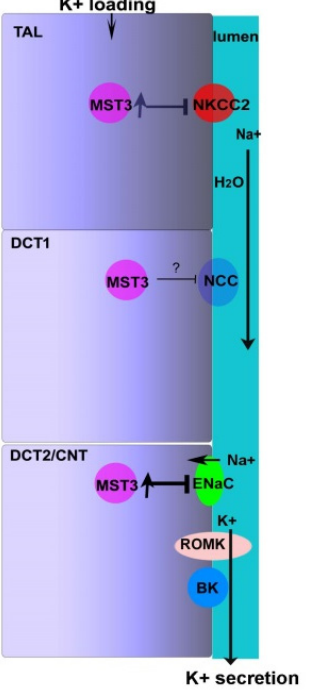
Figure 5. Hypothetical model of MST3 function on 2% KCl diets. NKCC2 and NCC in TAL and DCT1, respectively, are inhibited upon an increase in K + intake, thus, delivering Na + and water to the DCT2/CNT. Na + in the DCT2/CNT is reabsorbed through ENaC, resulting in K + secretion due to an electrochemical gradient. Reabsorption of Na + through ENaC at the DCT2/CNT prevents Na + loss. An increase in K + intake stimulates MST3 expression, which inhibits NKCC2 and ENaC expression at the apical membrane of the nephron, thus preventing excessive absorption of Na + and maintaining Na + homeostasis.